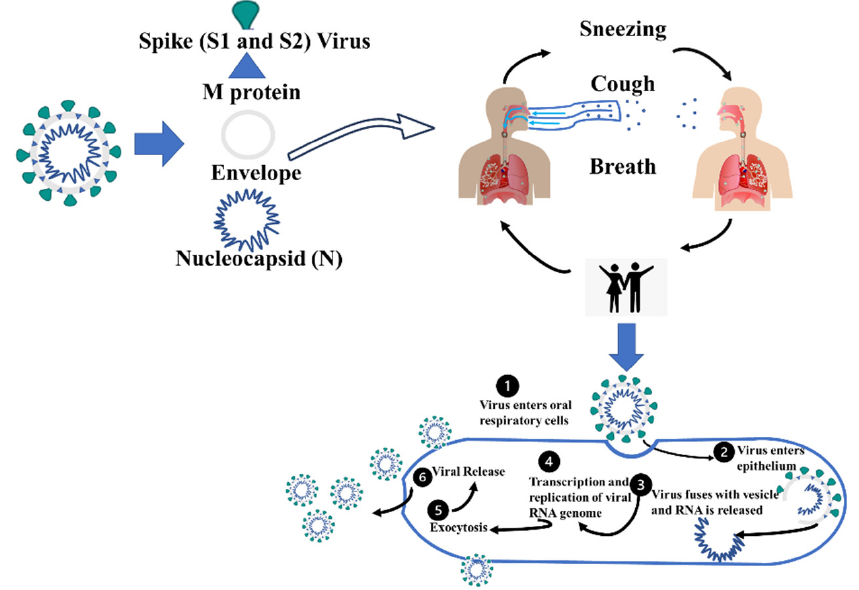
Figure 2. The infection cycle of SARS-CoV-2 (COVID-19). The life cycle summarizes the steps of how Coronavirus is transmitted and